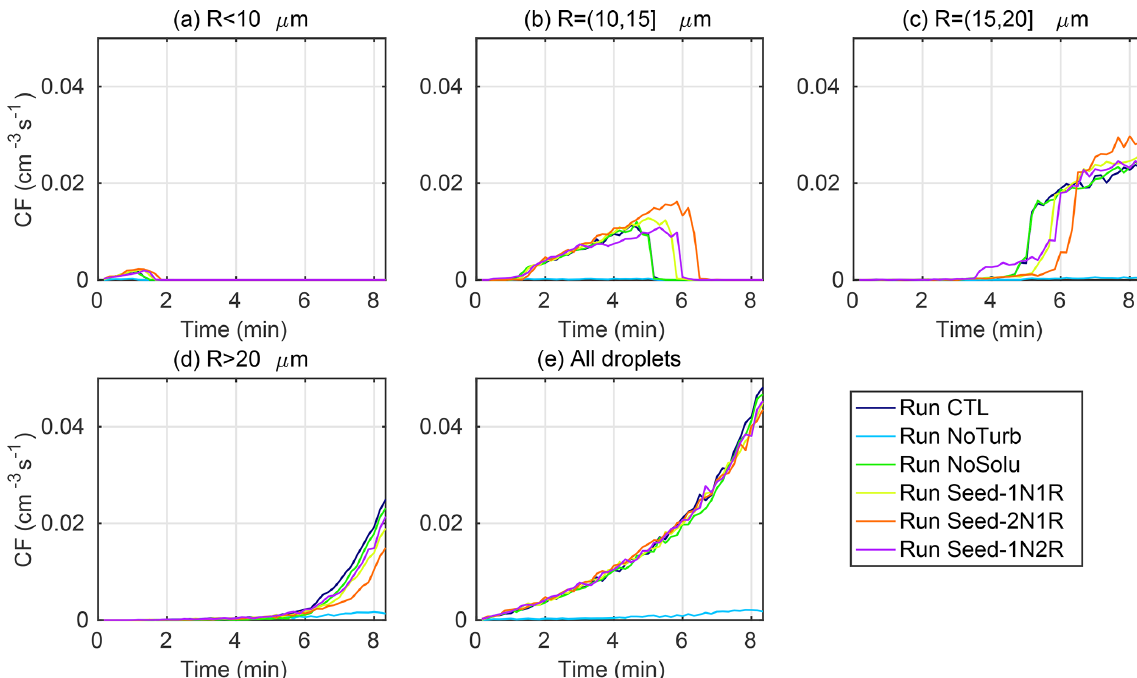
Figure 6. (a–d) Time evolution of collision frequency for droplet pairs of four different size groups mentioned in Fig. 5. (e) Time evolution of collision frequency for all droplet